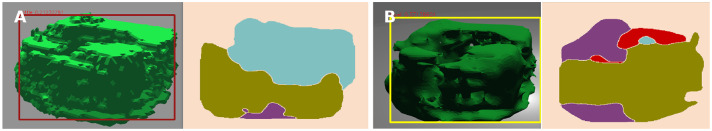
Affordance detection results using AffordanceNet (Do et al., 2018). (A) The AffordanceNet detector correctly identified support-ability (in light blue) and wrap-grasp-ability (in mustard color), and incorrectly identified hit-ability (in purple). (B) On a smoothed version of the object, and in different lighting conditions, AffordanceNet correctly identified wrap-grasp-ability (mustard), contain-ability (red), although with imperfect segmentation. It incorrectly identified hit-ability (purple) and support-ability (light blue).